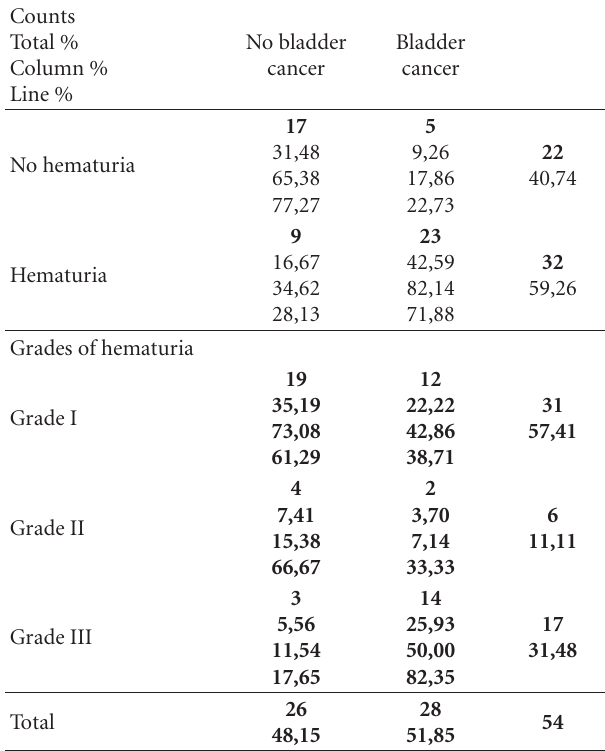
Table 1: Contingency table for the presence of bladder cancer and graded